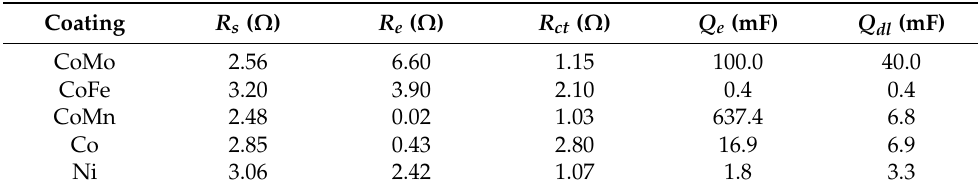
Scheme 1. Equivalent electric circuit used to fit the electrochemical impedance spectroscopy (EIS) data, where R s is the electrolyte resistance, R e is the electronic resistance of the material and the associated capacitance R ct is the resistance of the charge transfer reaction, Q e is the constant phase element, and Q dl is an ideal double-layer capacitor. Table 4. EIS parameters of the herein prepared coatings in 1 M KOH at –0.33 V (amplitude of 5 mV in the 100 kHz–0.1 Hz range). Coating CoMo